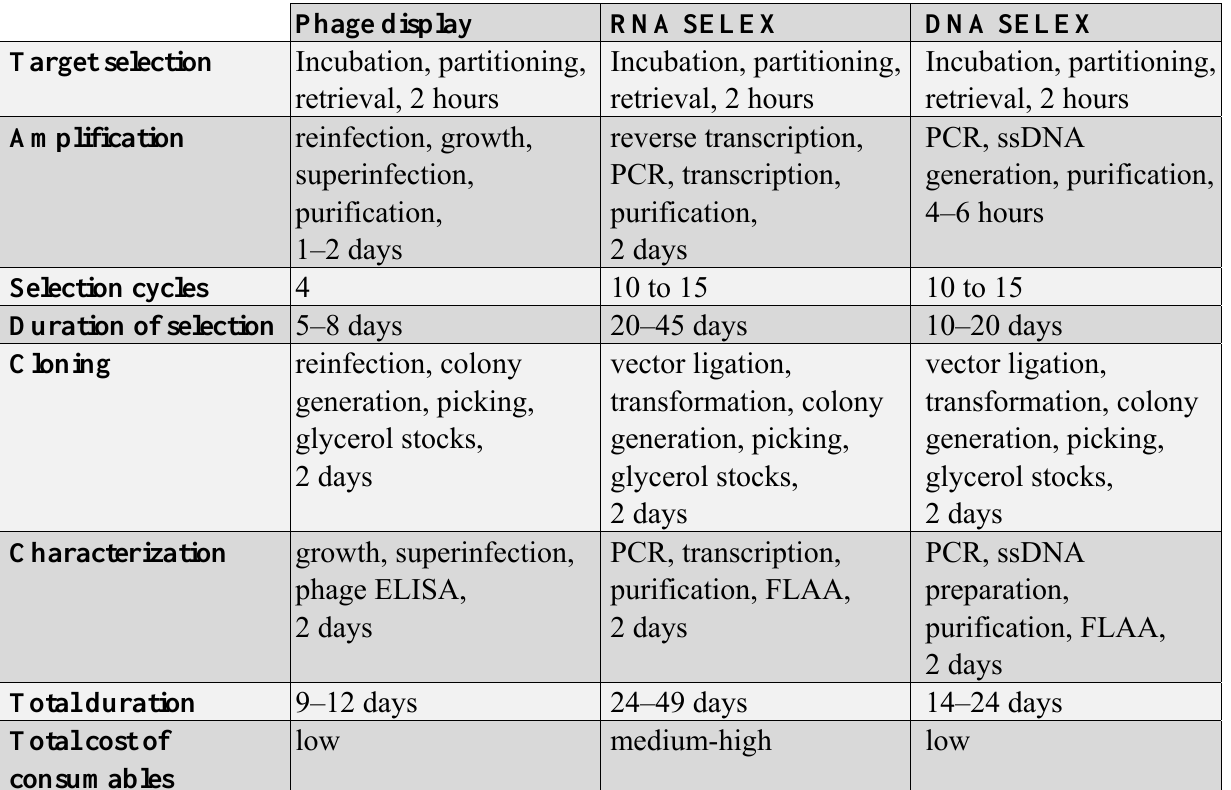
Table 3. Comparison of phage display and SELEX procedure with estimated duration of conventional